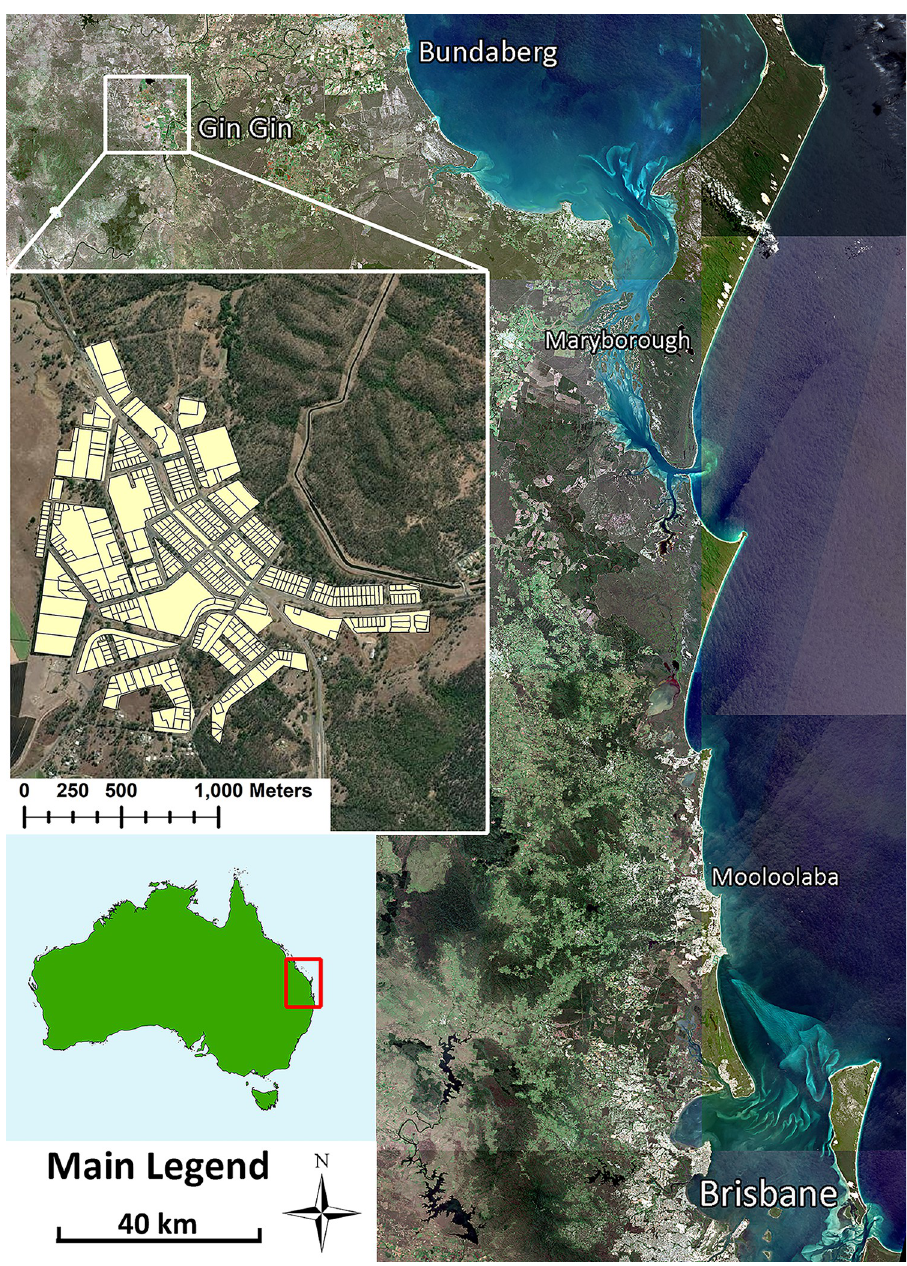
Fig 1. Location of the town of Gin Gin relative to Brisbane and South East Queensland. Location within Australia (bottom left) and Gin Gin town layout including scale (middle left). Map Source: Base Layer assembled from the Open Access Copernicus Australasia Regional Data Hub [27,28] and Australian map and residential features digitized from public domain cadastre data [29,30] in ArcGIS.